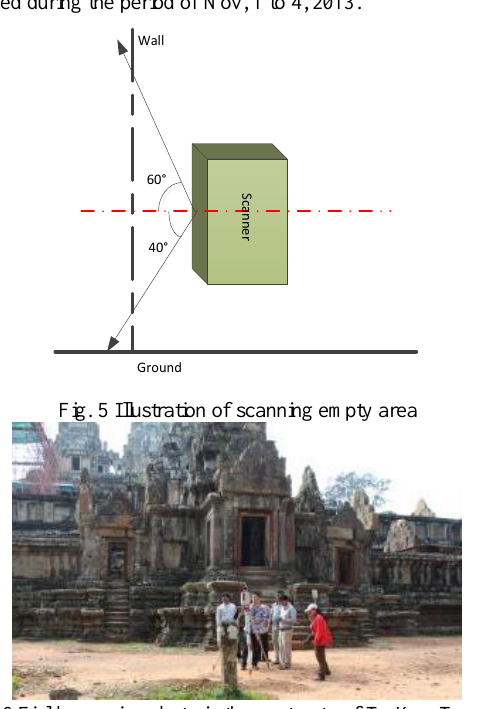
Fig.1 An overall of the Ta Keo Temple